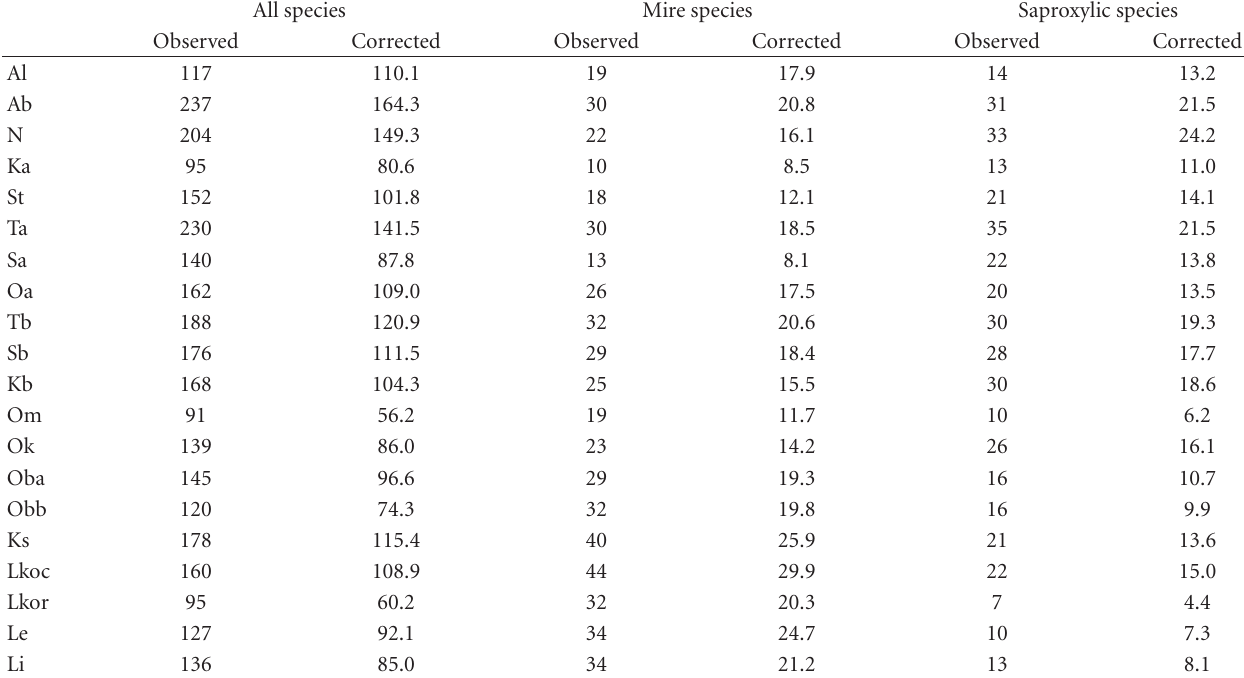
Table 2: Observed and corrected species richness of crane flies (Diptera, Tipuloidea) in Finnish biogeographical provinces for all species, mire-dwellers, and saproxylic/fungivorous species. All species Mire species Saproxylic species Observed Corrected Observed Corrected Observed Corrected